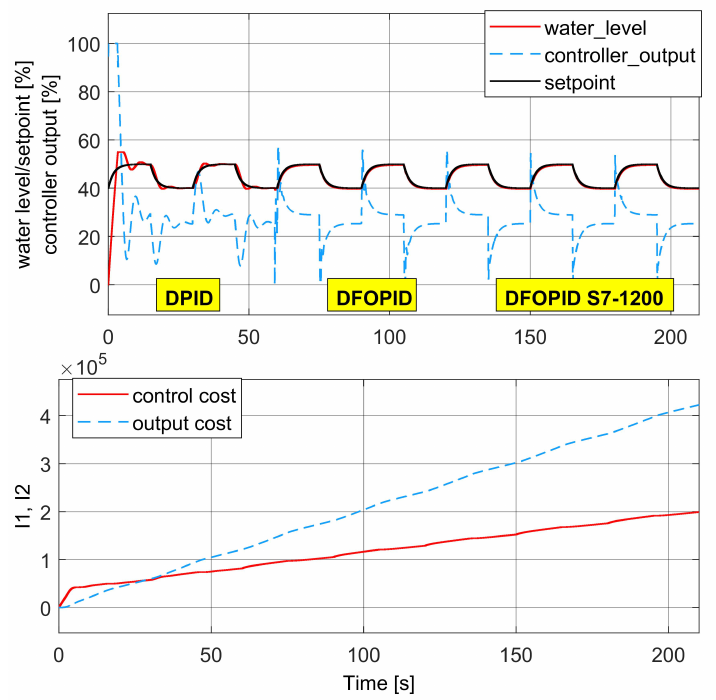
Figure 10. Comparison of DFOPID and DPID control system implementations on PLC and the Simulink